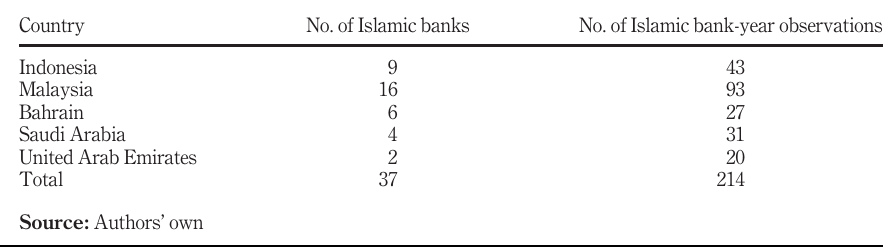
Table 1. Sample distribution